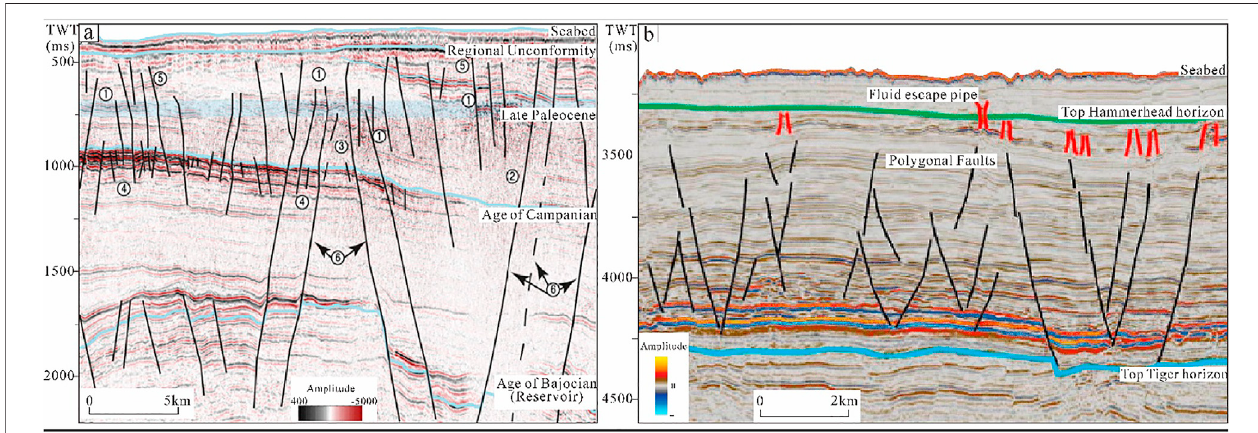
FIGURE 6 | (A) A seismic pro fi le in northeast direction in the Hammerfest Basin (modi fi ed from Ostanin et al. (2012)), showing Amplitude anomalies, Acoustic blanking, Incoherent/chaotic re fl ectors, Polygonal faults, PEEFs (Paleocene-Early Eocene Faults) and 1st order faults. (B) A seismic pro fi le in southwest direction in the Ceduna Sub-basin, offshore South Australia (modi fi ed from Velayatham et al. (2021)).